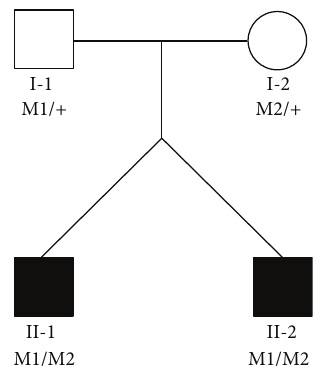
Figure 1: Pedigree of the LCA1H family. The nucleotide numbering reflects cDNA numbering with +1 corresponding to A of the ATG translation initiation codon in the reference sequence NM 000180, according to the nomenclature recommended by the Human Genome Variation Society (http://www.hgvs.org/mutnomen/). The initiation codon was designated as codon 1. The genotypes for the twins (II-1, II-2) and their parents (I-1, I-2) are shown with c.2113+2 2113+3insT denoted as M1 and c. 2714T > C (p.L905P) denoted as M2. Squares indicate males and circles indicate females. Filled symbols indicate individuals affected by Leber congenital amaurosis. M1/+ and M2/+ indicate heterozygous carriers. M1/M2 represents individuals presenting both mutations as compound